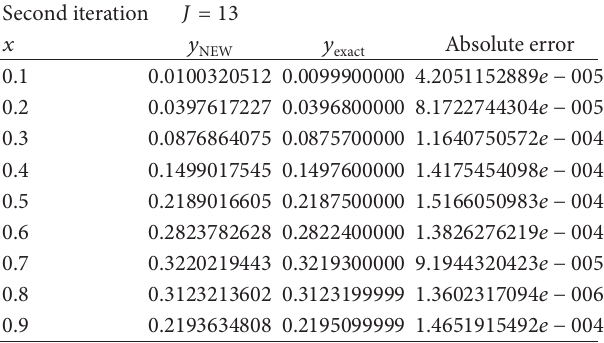
Table 6: Comparison of exact solution 𝑦 wavelet-Galerkin method with quasilinearization technique 𝑦 at second iteration: level of resolutions 𝐽 = 13 and 𝐷10 is used as Galerkin